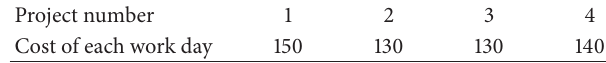
Table 1: Cost statistics of similar